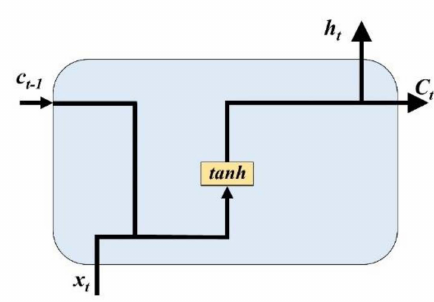
Figure 1. Standard recurrent neural network (RNN) module contains a single